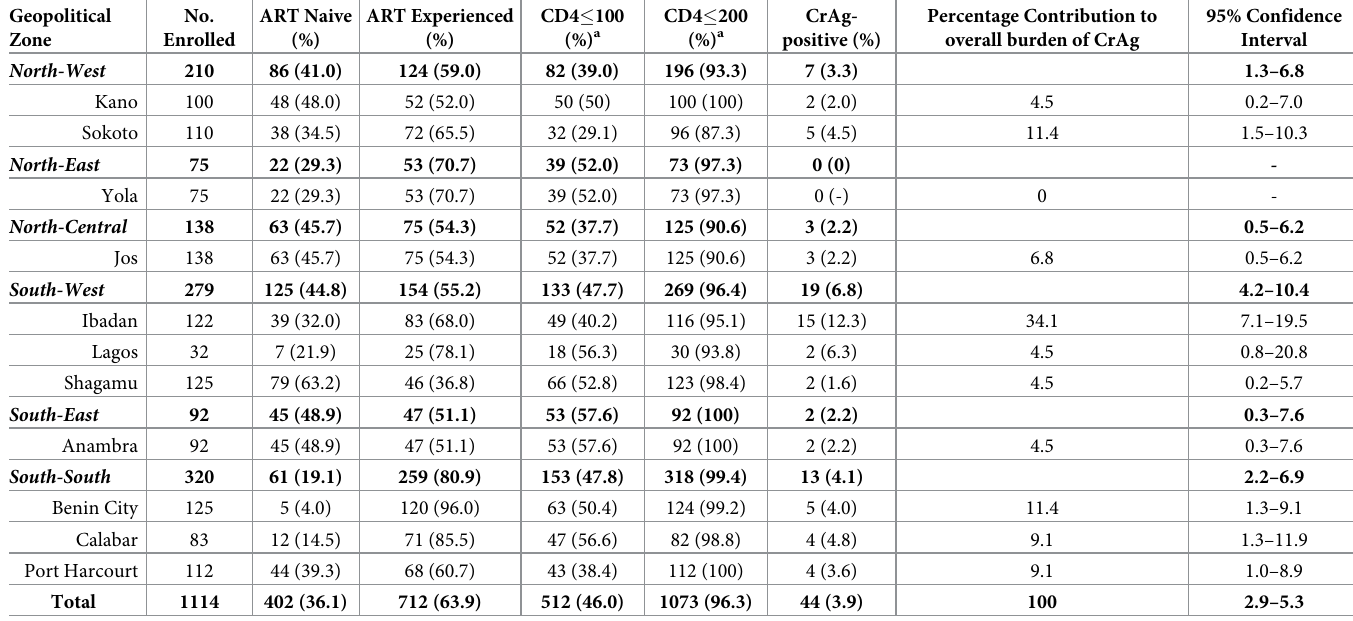
Table 2. Cryptococcal antigenemia by Geopolitical zone and health